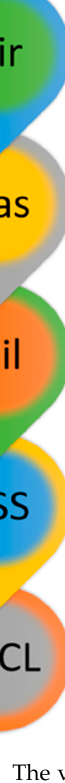
Figure 3. The vitreous substitutes are hereby represented as they would arrange in their resting position with respect to each other in a hypothetical vitreous chamber, according to their buoyancy property. Abbreviations: BSS, balanced salt solution; PFCL, perfluorocarbon liquid.